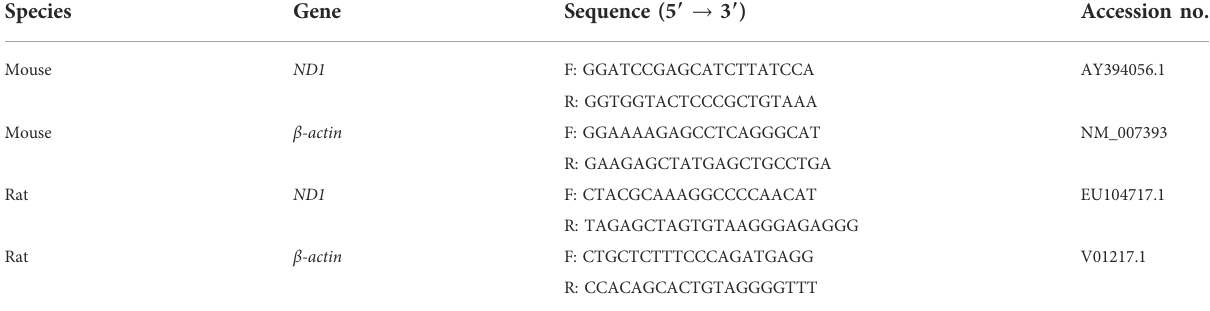
TABLE 1 Sequence of primers used for